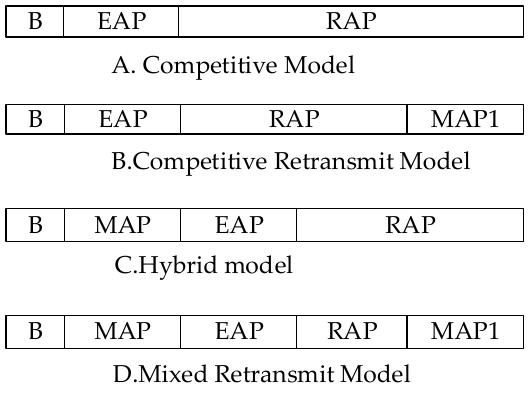
Figure 10. CLRS Protocol Superframe Classification.